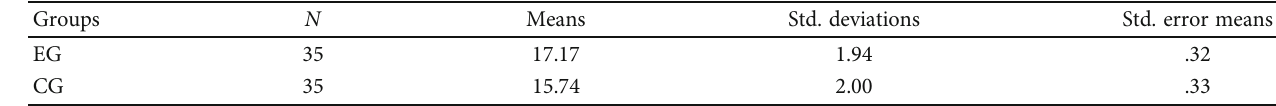
Table 3: Groups ’ listening posttest (descriptive statistics).